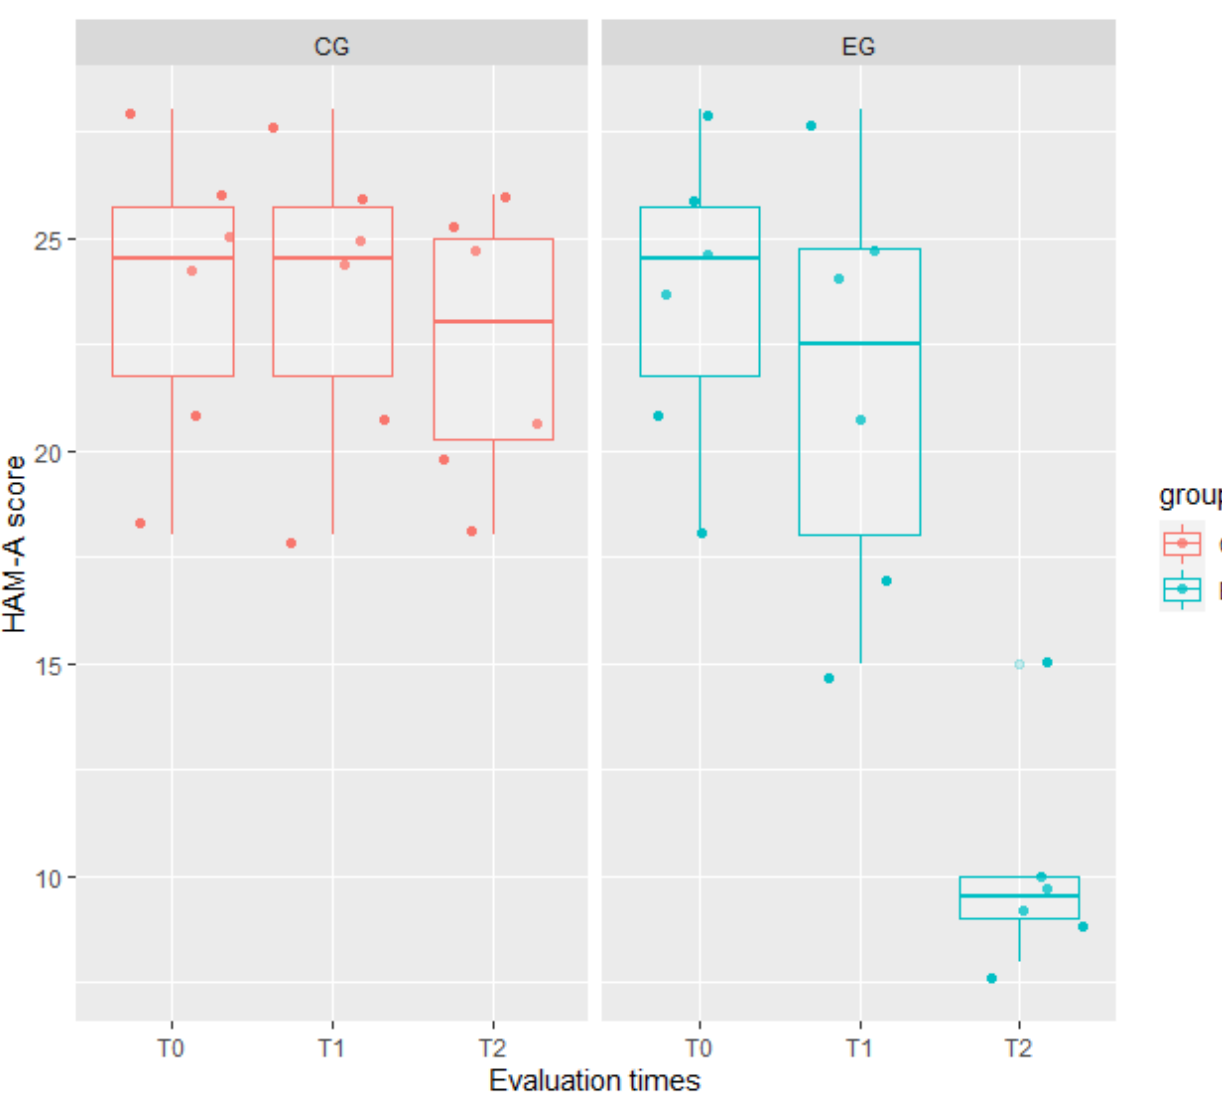
Figure 2. Comparison of anxiety scores (measured by HAM-A = Hamilton Rating Scale) between the experimental group (EG) in green, and the control group (CG) in red, at any evaluation time (T0, T1, and T2). Any box represents data distribution: the bounds at the top and bottom are the first and third quartiles, the center line is the median value, the whiskers from the box indicate the minimum and maximum values, dark (jittered) points represent patient HAM ‐ A scores, while clear points represent outliers. From T0 to T1, CG boxplots are similar while EG boxplots show a decrease in median score, more apparent from T1 to T2.